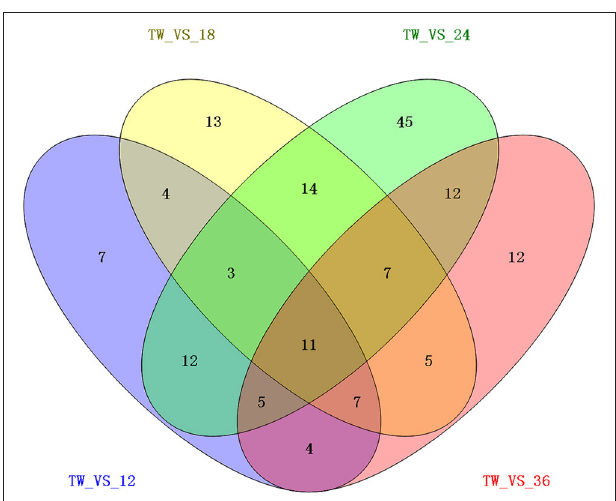
FIGURE 2 | A Venn diagram of differentially expressed immunity-related genes in P. xylostella at 12, 18, 24, and 36 h post-infection. The numbers in each circle show differentially expressed genes in each comparison treatment and the overlapping regions display genes that are commonly expressed among the comparison